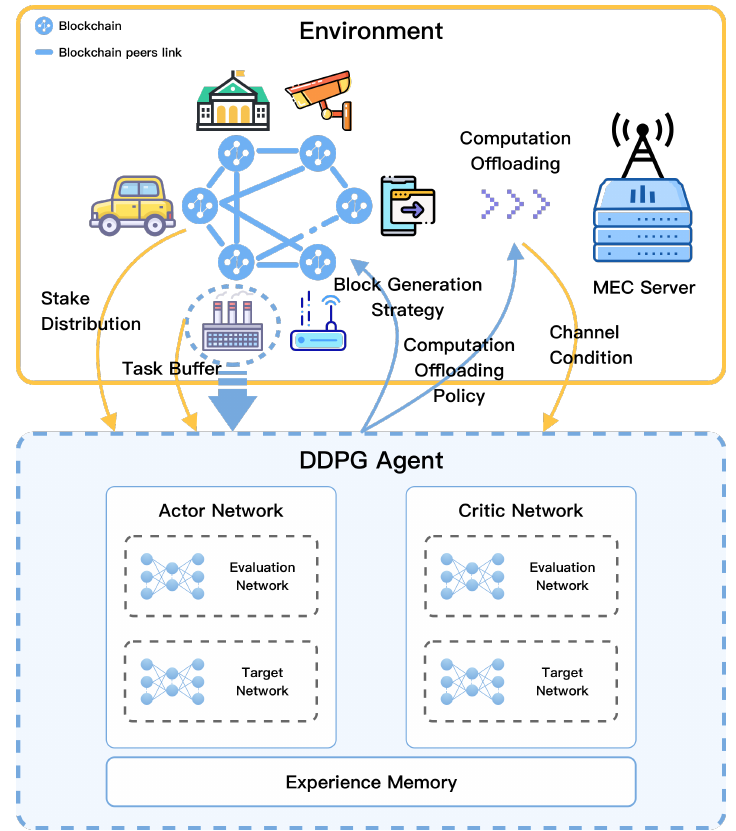
Figure 4. The architecture of the DDPG-based